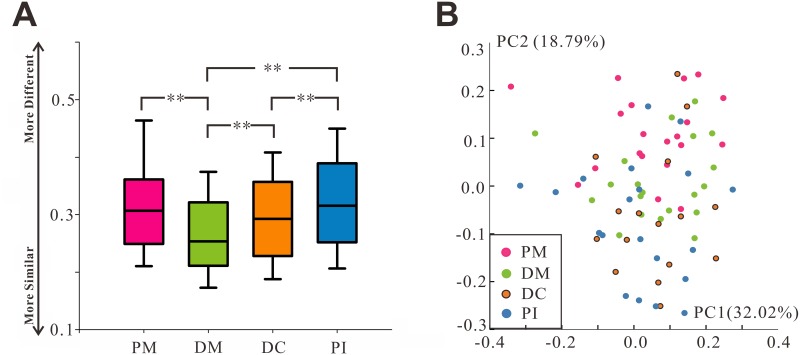
Microbial community variation within groups using weighted UniFrac distance.(A) The weighted UniFrac distance values of PM, DM, DC, and PI. PM and PI sites tended to host diverse bacterial communities, whereas DM and DC harbored similar microbial communities. All data are presented as medians and 10th, 25th, 75th, and 90th percentiles. **P < 0.01 by two-tailed t-test. (B) A principal coordinate analysis (PCoA) based on the weighted UniFrac distance values.